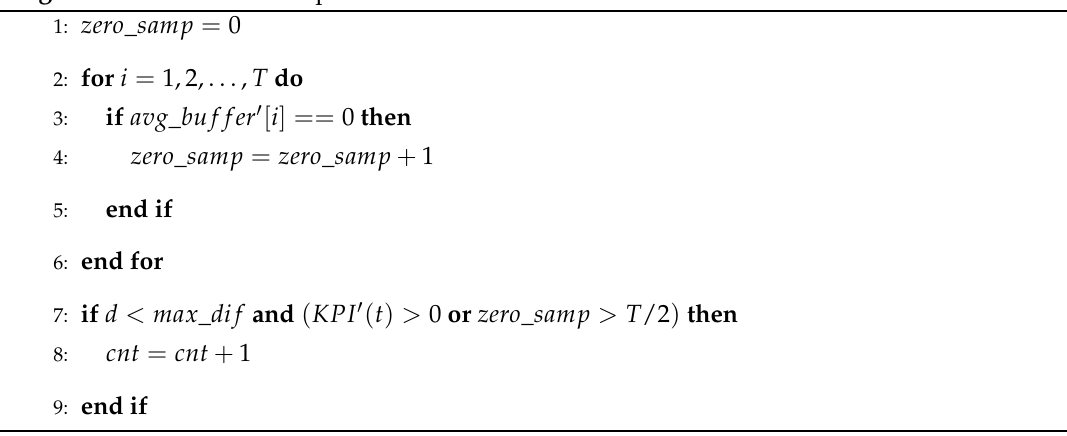
Algorithm 2: Border action